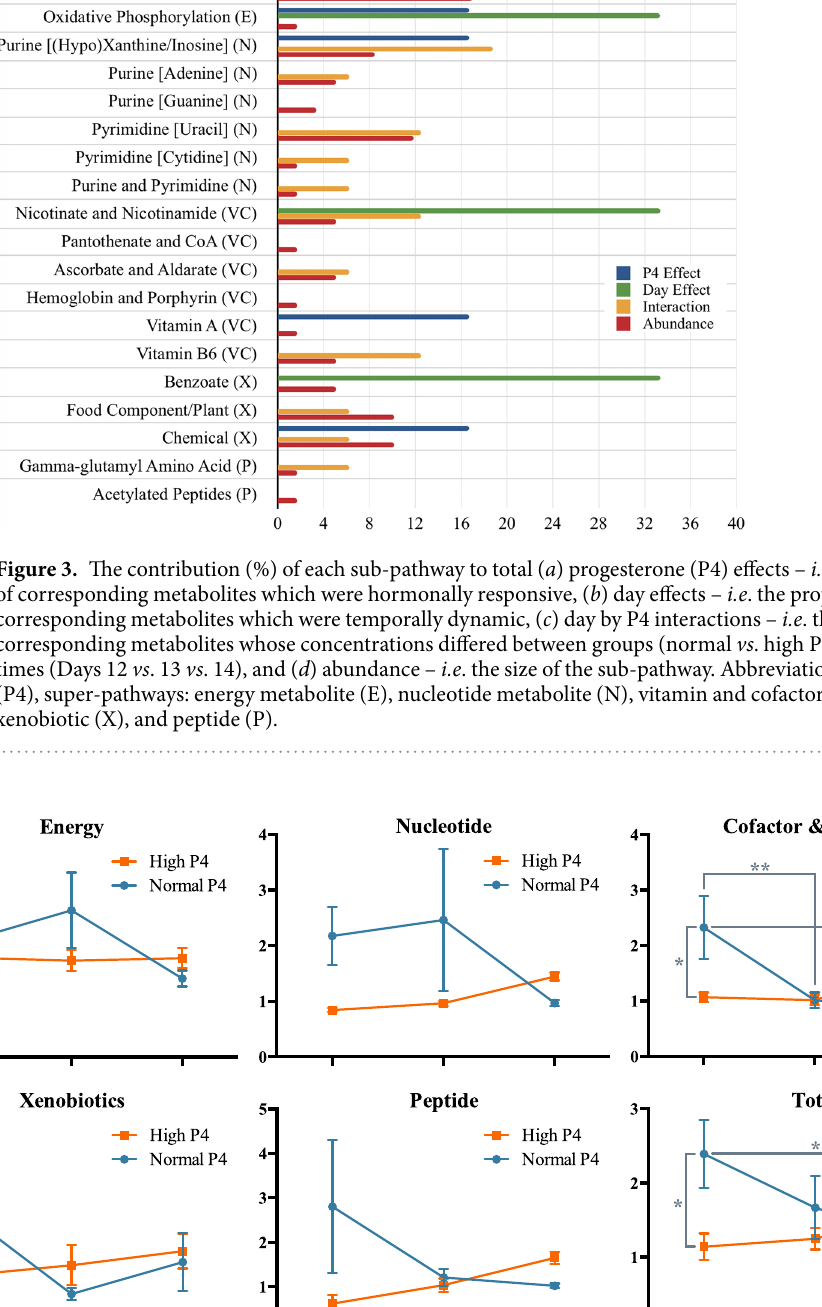
Regarding the corresponding pathways of the identified molecules, the most enriched by P4 ( n = 13, N = 59) – whereby E is the pathway enrichment, k refers to the number of significantly altered metabolites per pathway, m denotes the total number of detected molecules per pathway, n depicts the number of significantly altered metab- olites in the comparison, and N represents the total identified metabolites in the study – were gamma-glutamyl